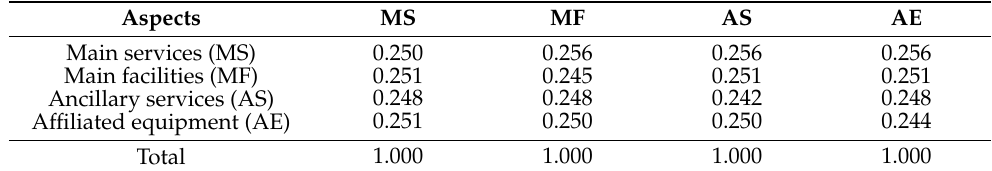
Table 11. Weighted